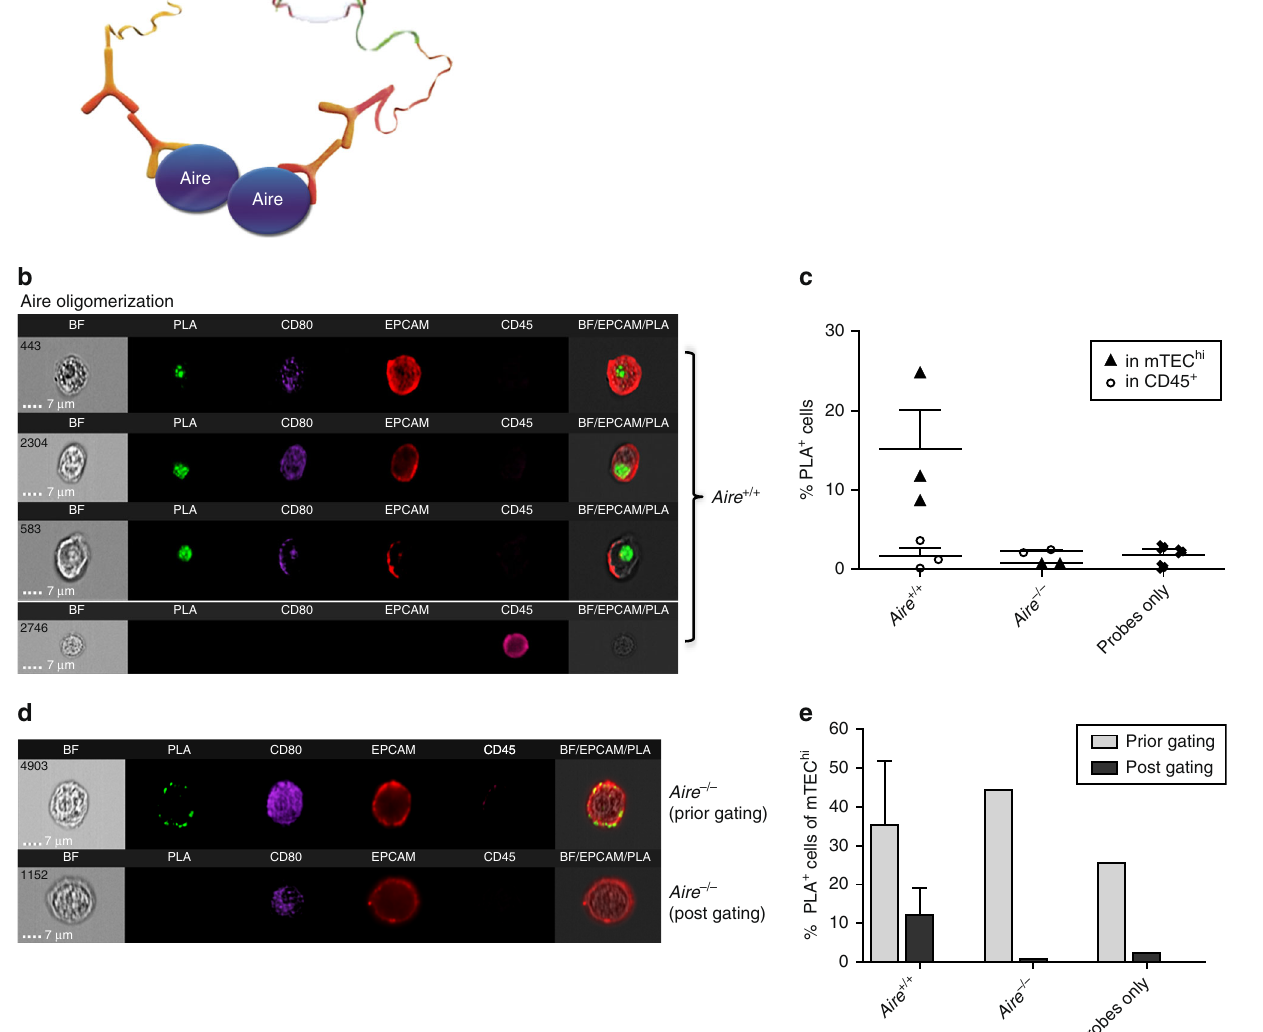
Fig. 2 PLIC quantitative analysis of protein oligomerization in mTECs. a A graphical scheme illustrating PLIC analysis of Aire oligomerization using a single monoclonal antibody. b PLIC analysis showing representative images of the oligomerization of Aire in mTEC hi and CD45 + populations, presented as (left to right): bright fi eld (BF), PLA (green), staining of CD80 (PB), EpCAM (APC), CD45 (APC/Cy7), and BF/PLA/EpCAM overlay (merged). c Quantitative analysis of Aire oligomerization (presented as the percentage of PLA + cells) in mTEC hi or CD45 + cells isolated from Aire + / + and Aire – / – mice, compared to probes background. Shown are values from three independent experiments. Each point on the graph (triangle for mTEC hi , circle for CD45 + , cross for probes only) represents an average value of single independent experiment, calculated from 2 to 4 biological replicates, +s.e.m. d Representative images of Aire oligomerization as detected by PLIC in mTEC hi isolated from Aire – / – mice, prior to corrected analysis gating and post gating ( fi ltering out false-positive signal). Images are presented as (left to right): bright fi eld (BF), PLA (green), staining of CD80 (PB), EpCAM (APC), CD45 (APC/Cy7), and BF/PLA/ EpCAM overlay (merged). Scale bar 7 μ M. e Quantitative analysis of Aire oligomerization (presented as the percentage of PLA + cells) in mTEC hi cells isolated from Aire + / + ( n = 2, s.e.m) or Aire – / – ( n = 1) mice, compared to probes background sample ( n = 1), prior to (light grey) and post (dark